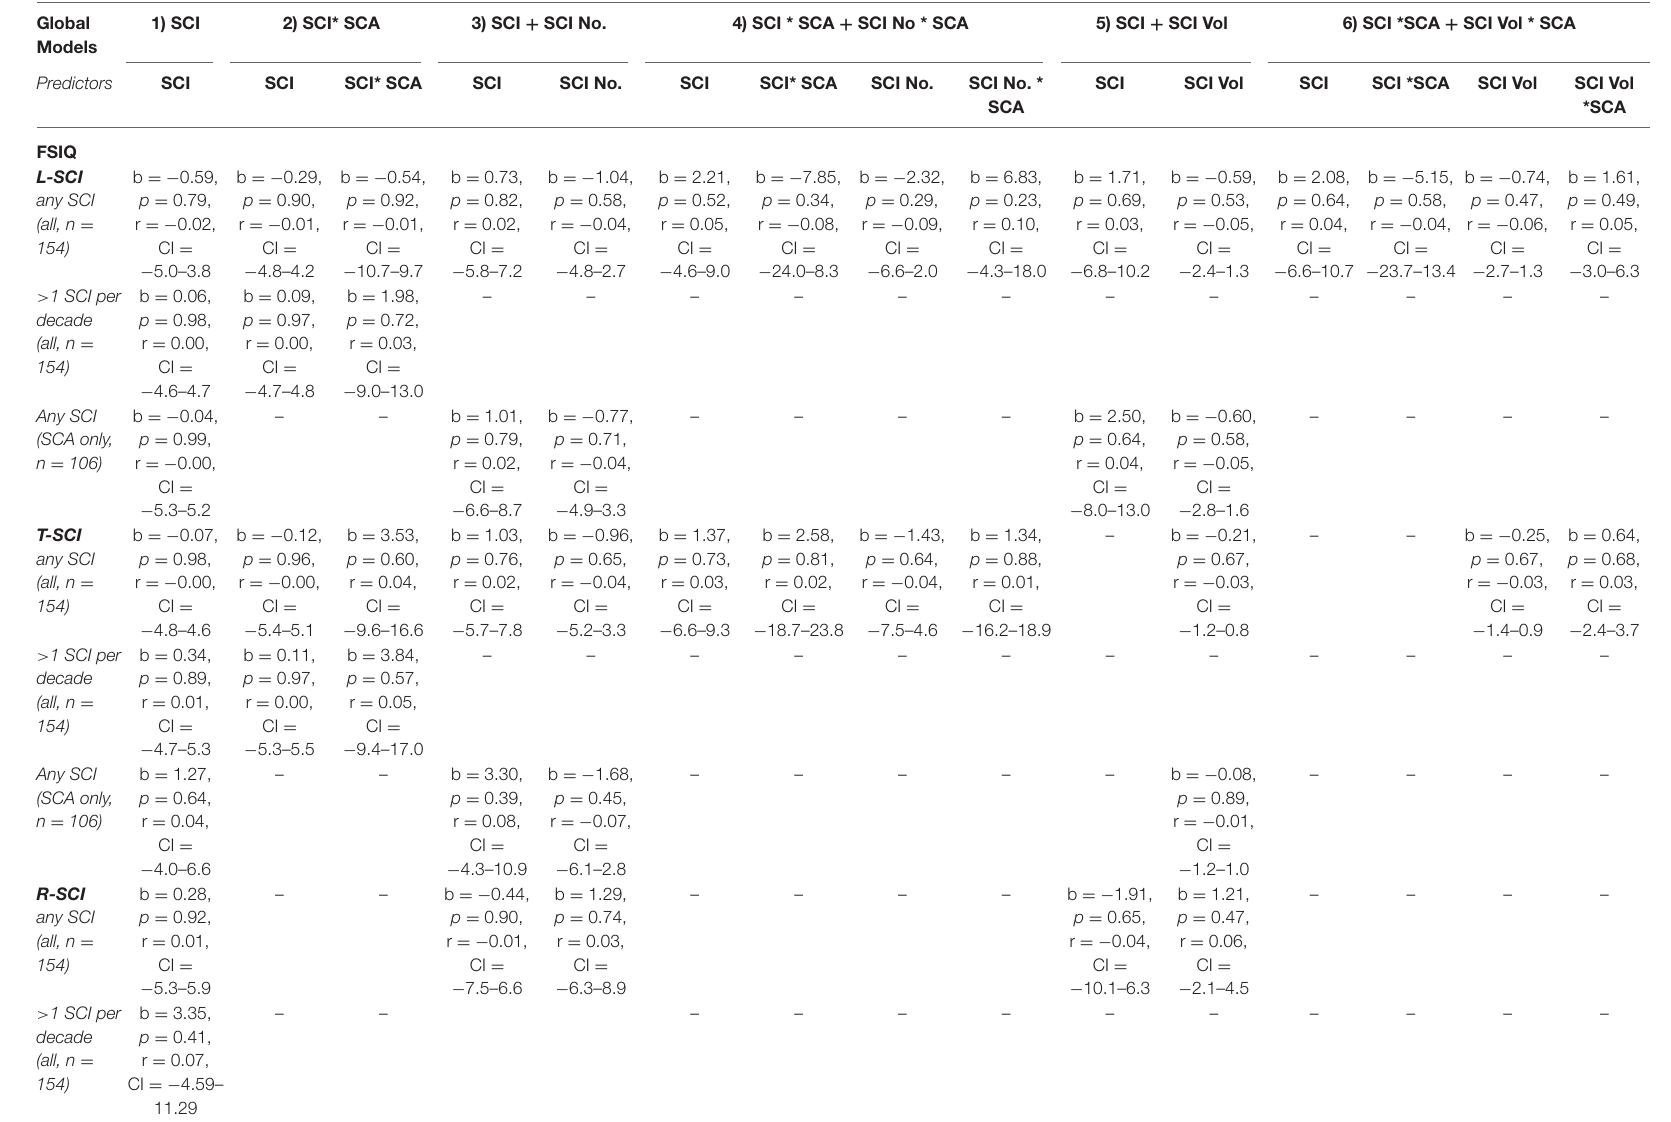
TABLE A1 | Global regression